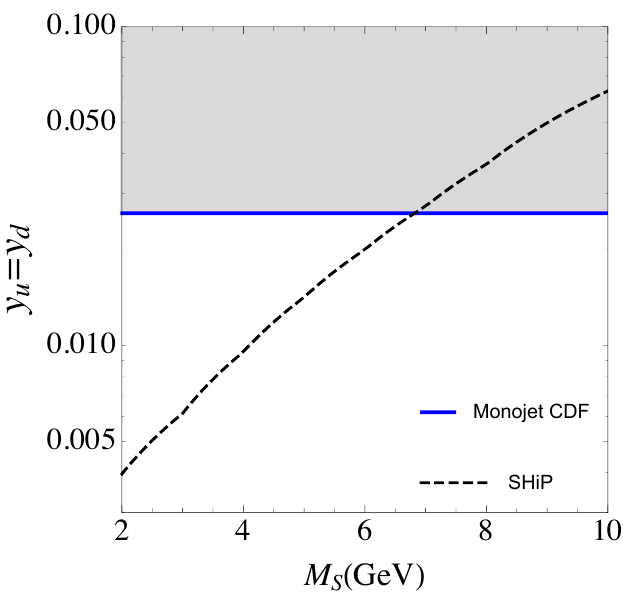
Figure 9. Sensitivity plot to a GeV scalar mediator at a SHiP like experiment obtained with MadDump assuming 9 (cid:2) 10 5 neutrino DIS events compared to existing bounds from CDF [7, 41].The DM mass has been (cid:12)xed to 750 MeV.